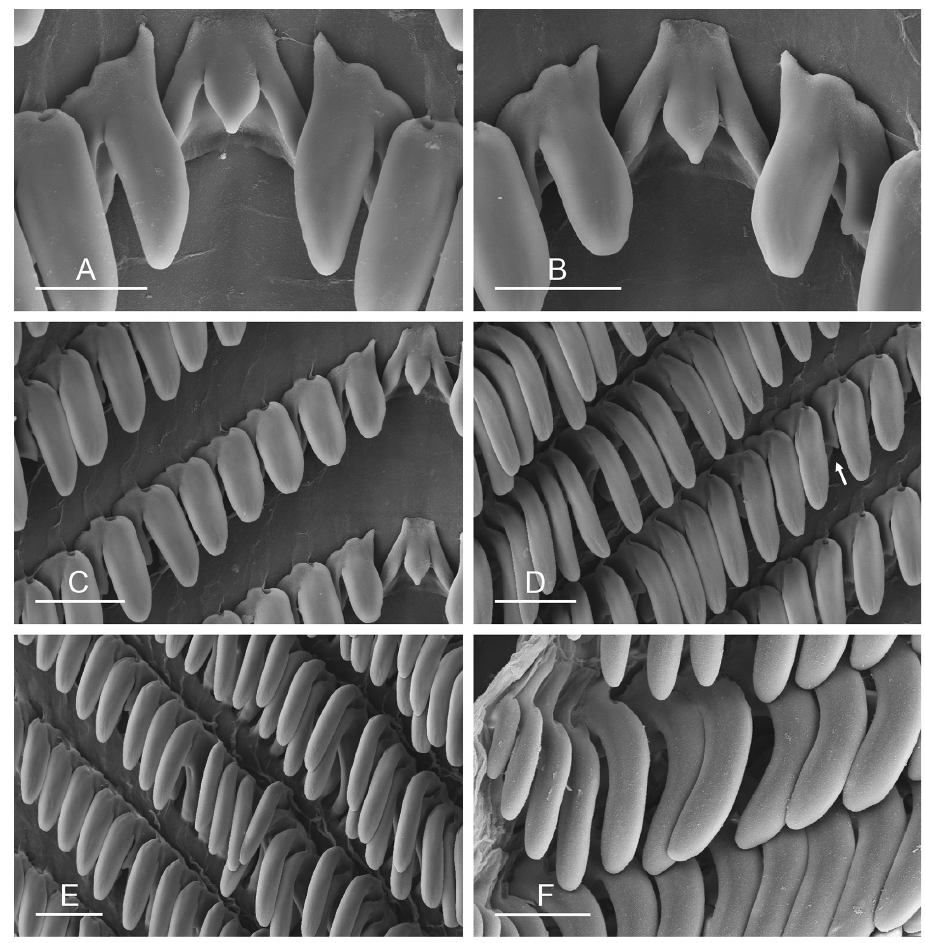
Figure 56. Radula, Wallaconchis comendadori . A Rachidian and innermost lateral teeth, Philippines, Bo- hol, scale bar 20 μm [3385] (PNM 041234) B Rachidian and innermost lateral teeth, Indonesia, Lombok, scale bar 20 μm [2985] (UMIZ 00063) C Rachidian and inner lateral teeth, scale bar 30 μm, same as B D Transition between inner lateral teeth and outer lateral teeth, arrow shows basal lateral spine, scale bar 30 μm, same as B E Transition between inner lateral teeth and outer lateral teeth, scale bar 30 μm, same as B F Outermost lateral teeth, Indonesia, Ambon, scale bar 20 μm [3539] (UMIZ